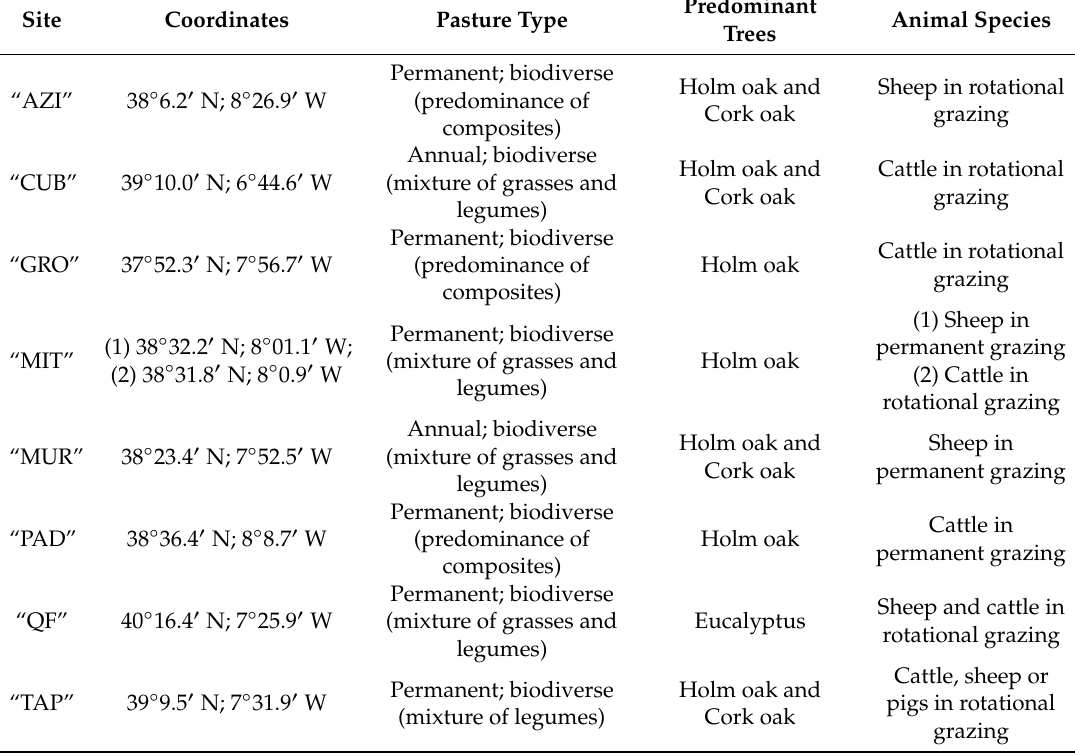
Figure 3. Location of the experimental fields in Portugal. Table 1. Characteristics of the experimental fields used in this study.